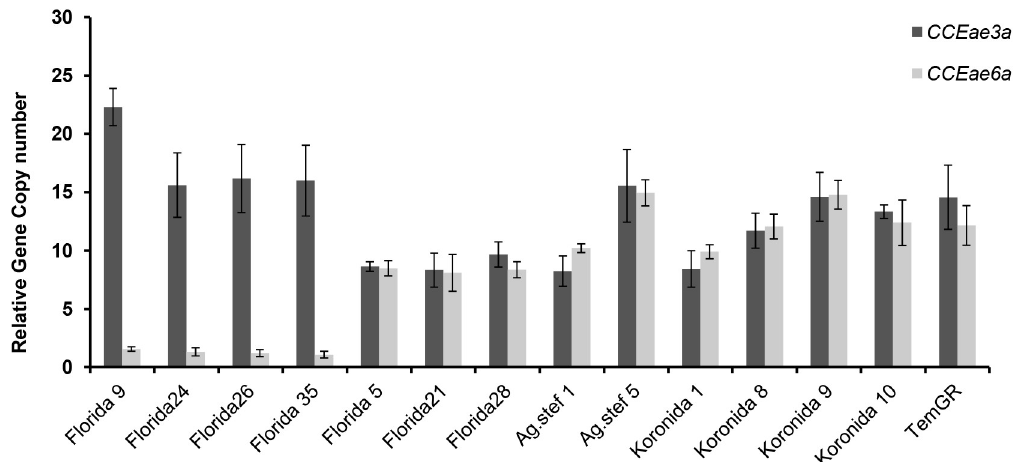
Fig 2. CCEae3a and CCEae6a gene copy number variation in individuals from Florida and Greece. Quantitative real time PCR values are representedrelativelyto the values of reference individuals from the Lab strain. Error bars represent the standard error of the mean from at least three technical replicates. Histone 3 and rpl34 have been used as reference genes.